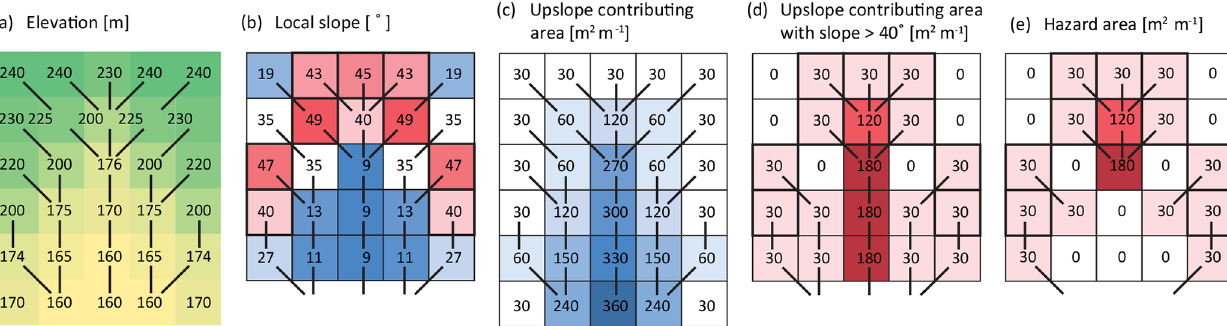
Figure 2. SHALRUN-EQ hazard area calculations for a simplified (steepest flow path) example with an initiation angle of 40 ◦ and a stopping angle of 10 ◦ : (a) elevations from a 30m resolution digital elevation model for an area of topographic convergence, where lines show flow paths from cell to cell; (b) local slope with thick outlines showing cells steeper than 40 ◦ ; (c) upslope contributing area; (d) upslope contributing area steeper than 40 ◦ ; and (e) hazard area, i.e. the upslope area steeper than 40 ◦ with flow paths that do not fall below 10 ◦